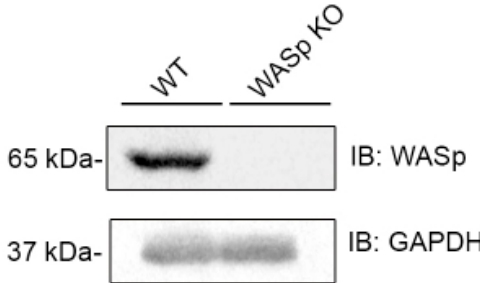
Figure 2. CRISPR Cas9 knockout of WASp in YTS-2DL1 cells. YTS-2DL1 cells and YTS-2DL1 WASp KO were lysed and subjected to western blot with anti-WASp and anti-GAPDH